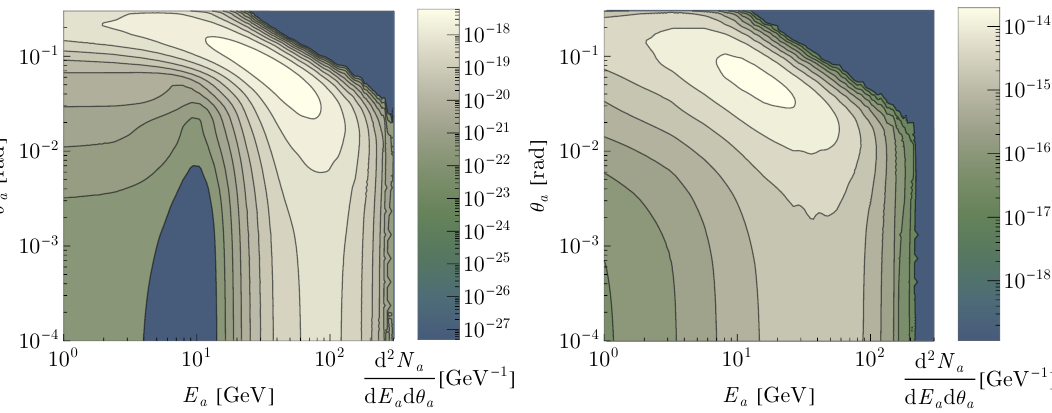
Figure 2 . Production differential yield of an m a = 0 . 5 GeV ALP produced in decays B ± , 0 → K ± , 0 + a (left) and D ± , 0 → π ± , 0 + a (right) of B and D produced at a copper target with 400 GeV proton beam assuming a referential value BR